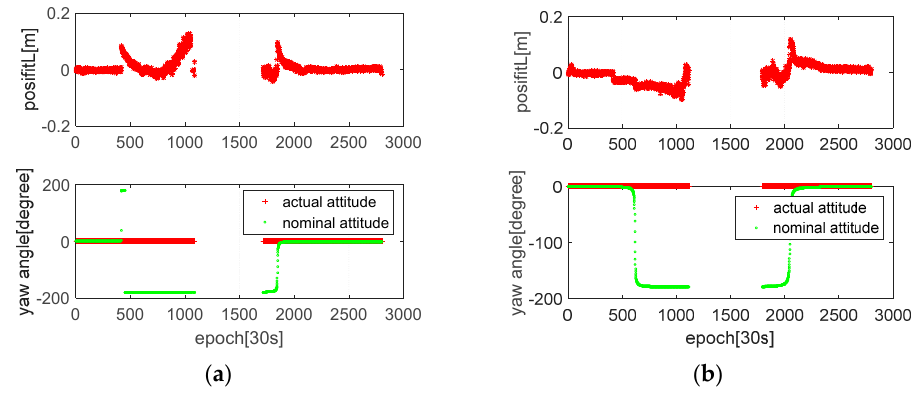
Figure 12. The phase residuals of: BDS C07 ( a ); and C10 ( b ) with strategy 2 (JFNG station, DOY 195 of 2017, the sampling rate is 30 s).